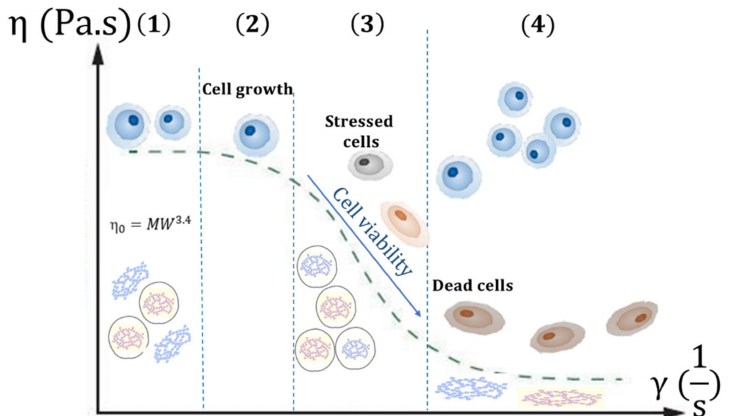
Figure 3. Shear − viscosity profile and respective cell behavior: ( 1 ) Zero shear viscosity; (2); Poly- dispersity –increases with broader MW; (3) Shear-thinning—Linear region—ideal conditions for extrusion; (4) Infinite shear-rate